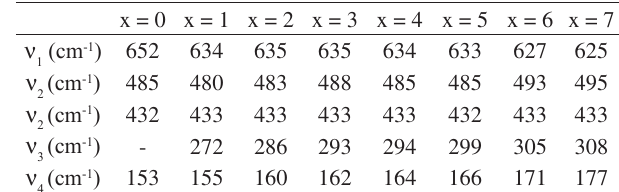
Zn Sb O (x = 0 - 7) x 7-x 2 12